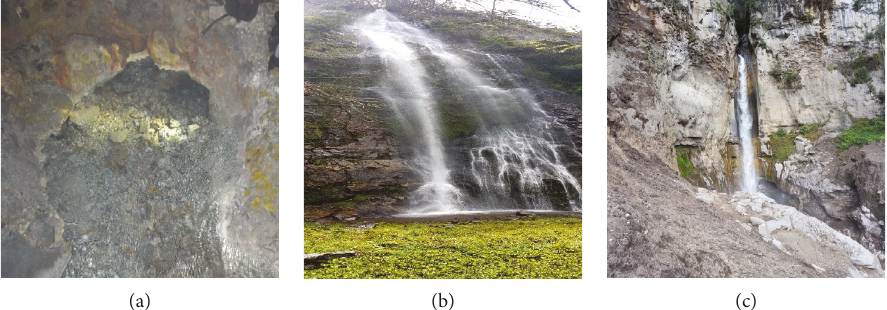
Figure 3: (a) Upwelling of the mine placed at approximately 1700 m inside the sulfur mine, (b) waterfall of Ichiago, and (c) waterfall of San